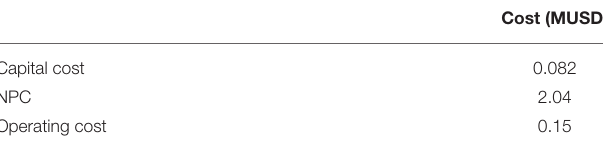
TABLE 7 | Solar powered optimized